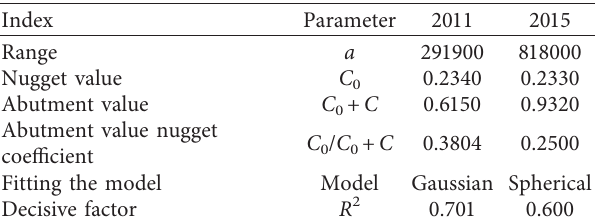
Figure 5: LISA spatial agglomeration of green utilization efficiency of urban construction land at different time periods: (a) 2011 and (b) 2015. Table 3: Variability function fitting parameters of green utilization efficiency pattern of urban construction